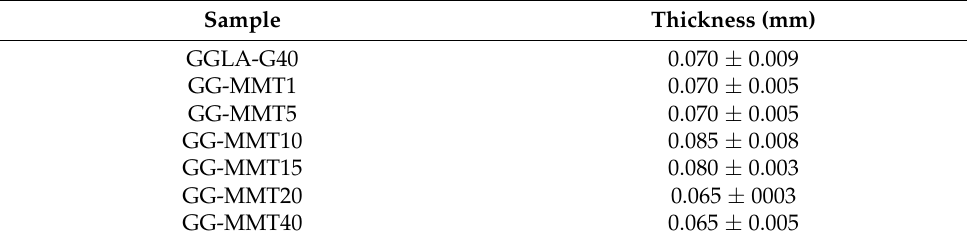
Table 6. Thicknesses of GGLA-G40 and GGLA/Na + SYN-1